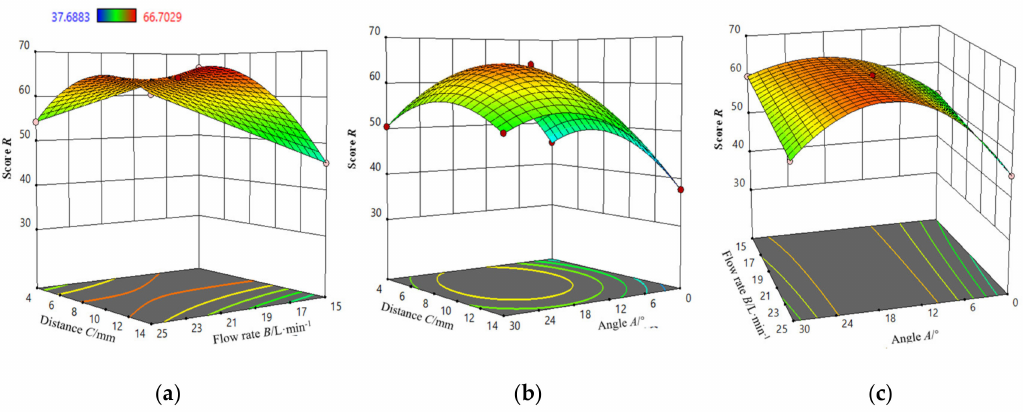
Figure 8. Analysis by 3D response surface of auxiliary gas scoring, ( a ) nozzle angle of 15 ◦ , ( b ) gas flow of 20 L · min − 1 , ( c ) nozzle distance of 9